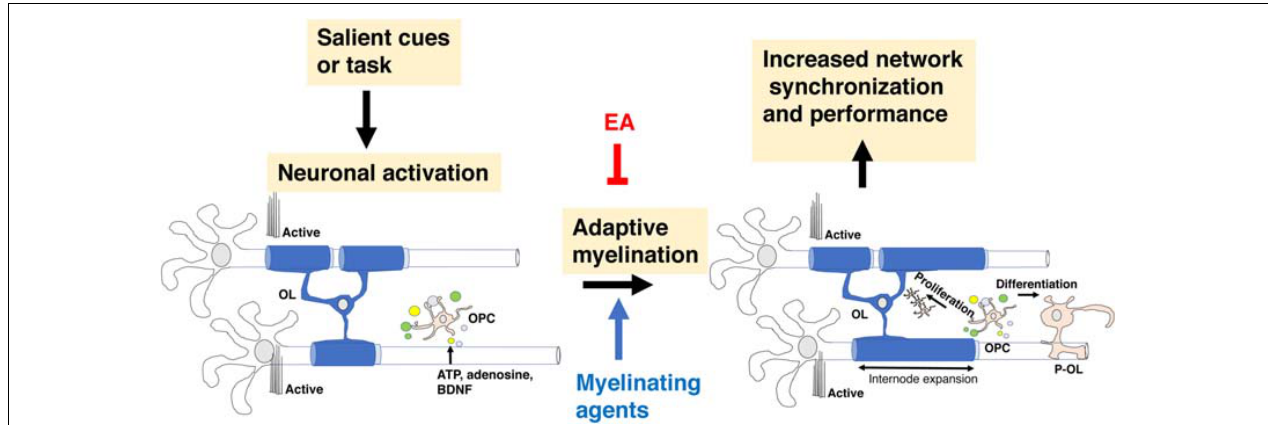
FIGURE 2 | Adaptive myelination in adulthood. Environmental cues increase neuronal activity in specific circuits, leading to the release of ligands such as glutamate, adenosine and BDNF (small colored circles) that promote the expansion of existing internodes. In adult rodents, these ligands drive OPC proliferation and differentiation but this aspect of de novo myelination seems negligible in healthy adult humans. Adaptive myelination in adulthood increases network synchronization and improves performance in a variety of tasks. Myelinating agents such as Clemastine fumarate increase adaptive myelination while some forms of EA or prolonged social deprivation in adulthood impair it. EA, early adversity; OL, mature oligodendrocyte; OPC, oligodendrocyte progenitor cell.